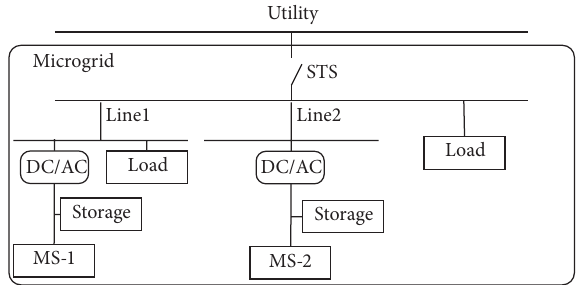
Figure 1: Microgrid